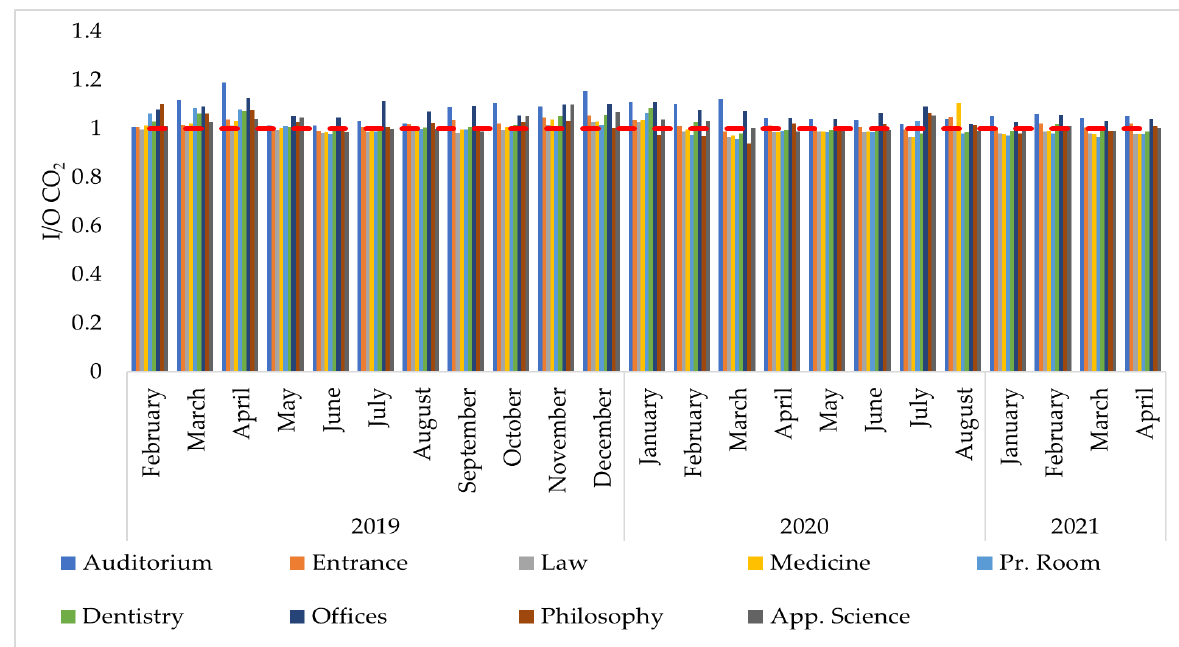
Figure 10. Indoor to outdoor (I/O) ratio of CO 2 levels within the museum during the entire experimental period.